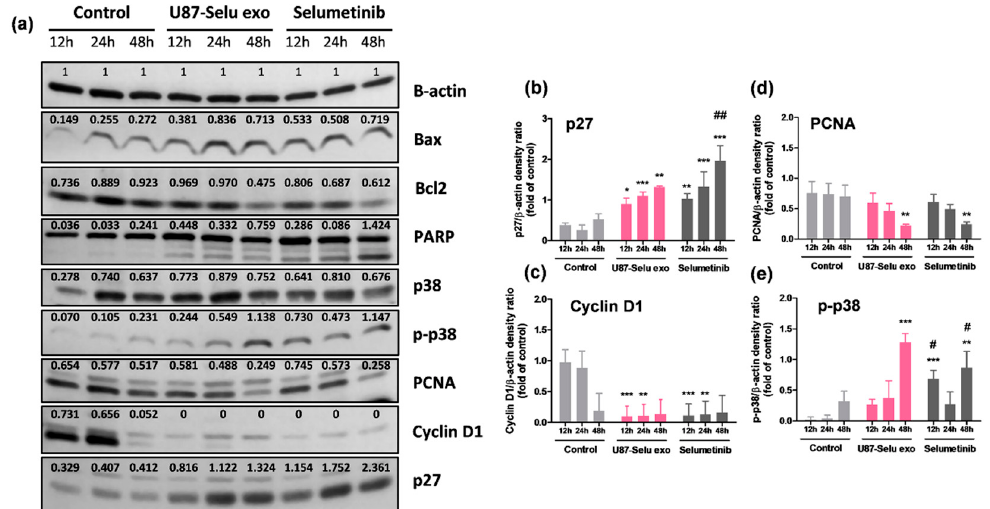
Figure 12. Apoptosis caused by U87-Selu exo in U87MG cells. ( a ) Western blot of U87MG cells treated with U87-Selu exo and selumetinib. ( b ) p27 expression levels at 12, 24, and 48 h. ( c ) PCNA expression levels at 12, 24, and 48 h. ( d ) Cyclin D1 expression levels at 12, 24, and 48 h. ( e ) p-p38 expression levels at 12, 24, and 48 h. * p < 0.05, ** p < 0.01, *** p < 0.001 vs. non-treated control for each time point; # p < 0.05, ## p < 0.01 vs. U87-Selu exo. n = 3.